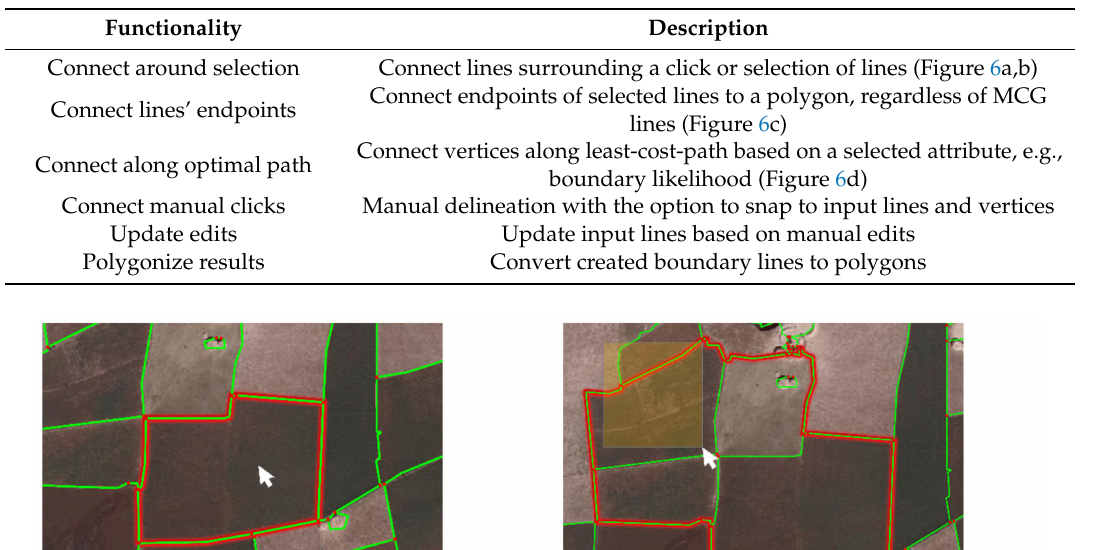
Table 2. Delineation functionalities of BoundaryDelineation QGIS plugin.